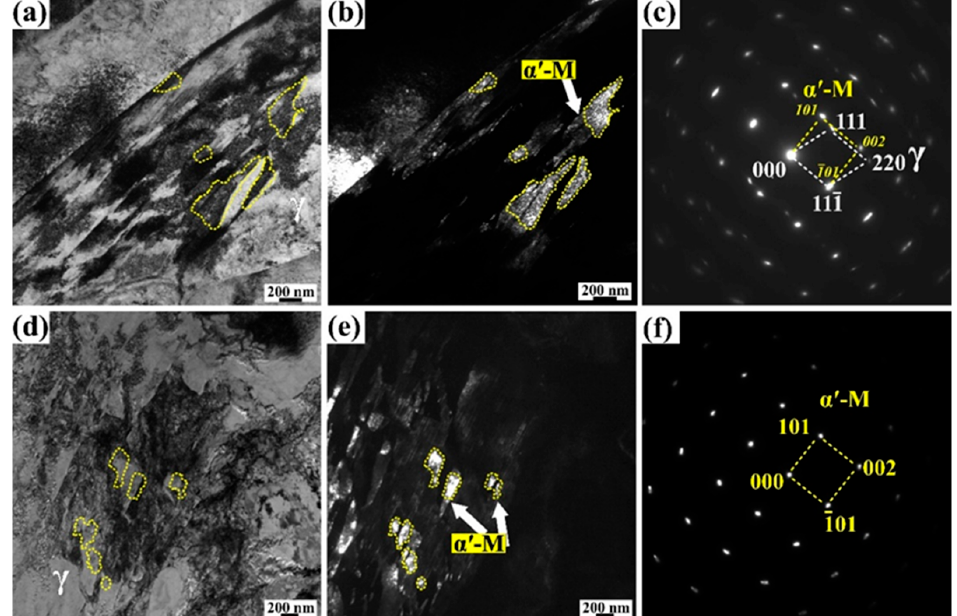
Figure 7. TEM micrographs of Cr19 and Cr19 + W DSS near the fracture surface after solution treatment at 1050 °C for 30 min, ( a ) bright field image of α′ -M in Cr19 DSS, ( b ) dark field image of α′ -M in Cr19 DSS, ( c ) corresponding TEM SADP; ( d ) bright field image of α′ -M in Cr19 + W DSS, ( e ) dark field image of α′ -M in Cr19 + W DSS, and ( f ) corresponding TEM SADP.